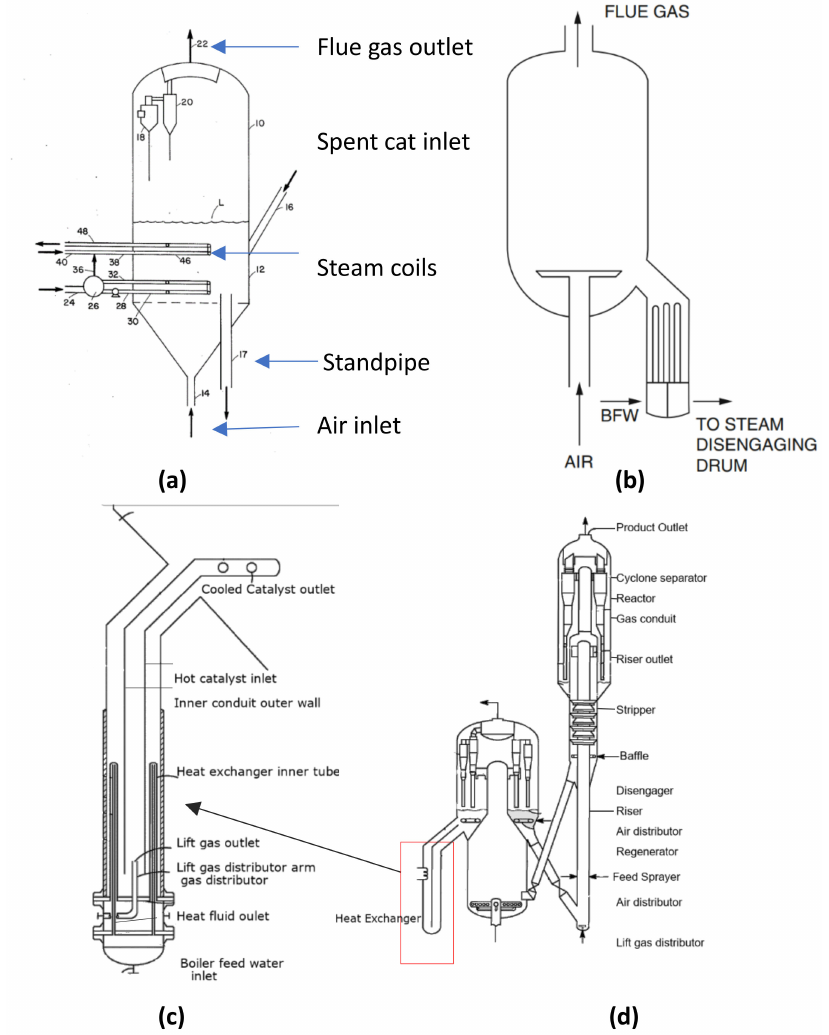
Figure 4. Catalyst cooler in FCC regenerator designs: ( a ) internal cooler, ( b ) backmix external cooler, ( c ) flow-through external cooler, ( d ) FCC resid cracker (adopted from Jones and Treese [14] and Palmas and Myers